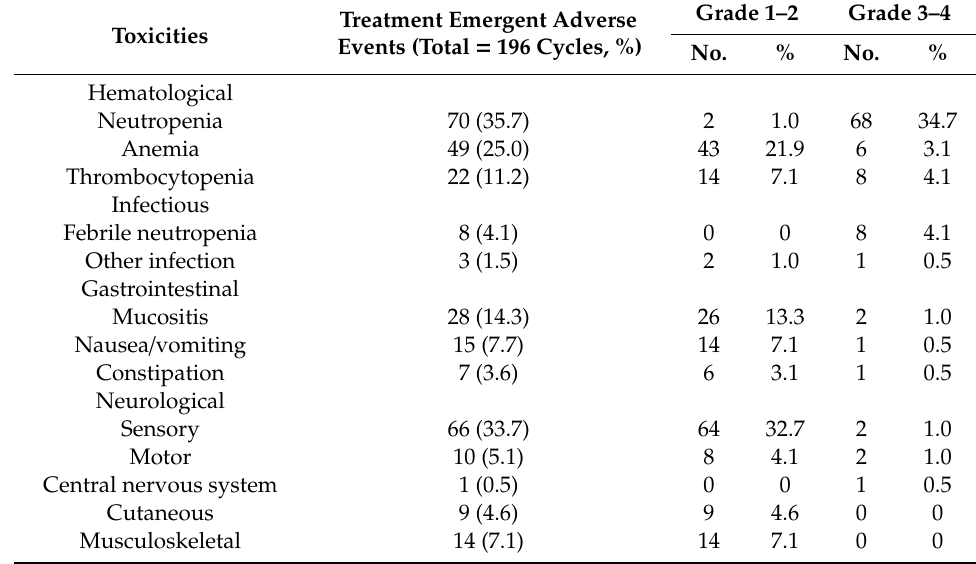
Table 2. Hematologic and non-hematologic toxicity profiles.